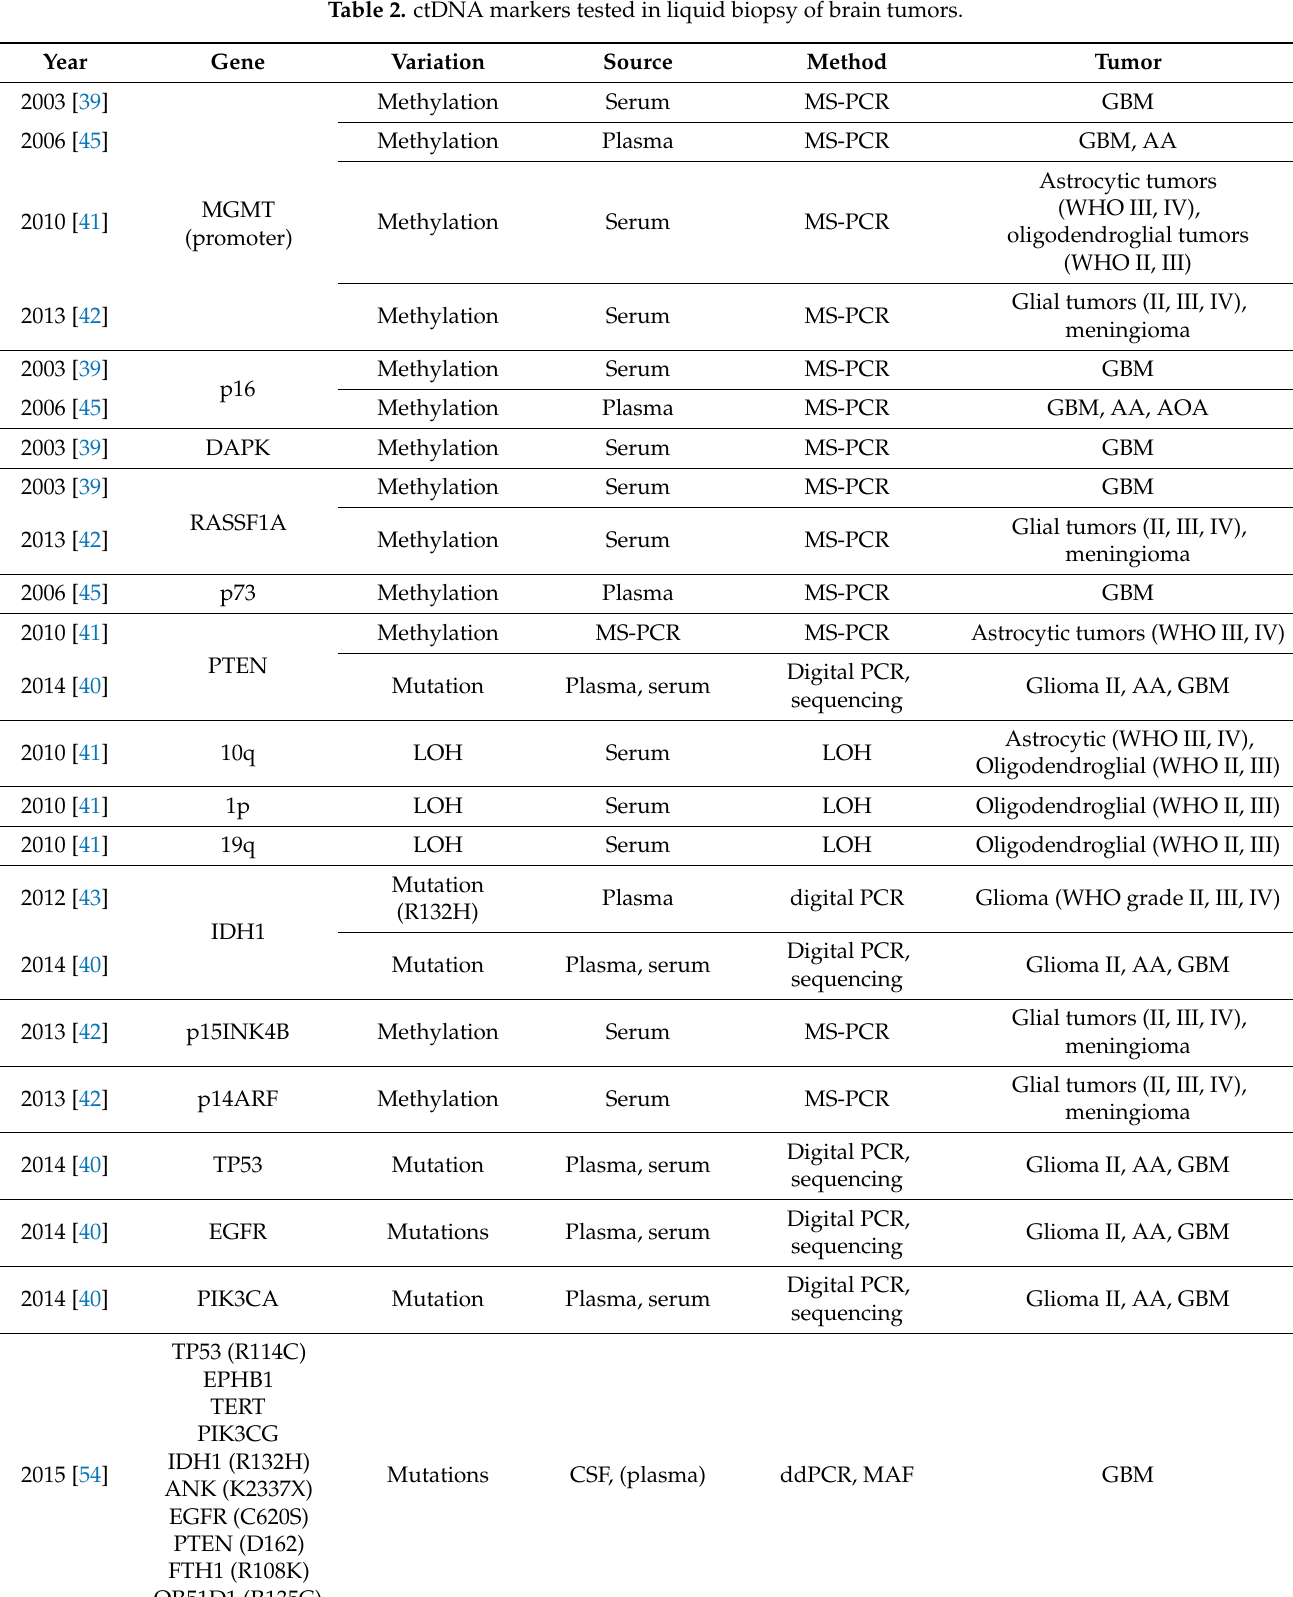
Table 2. ctDNA markers tested in liquid biopsy of brain